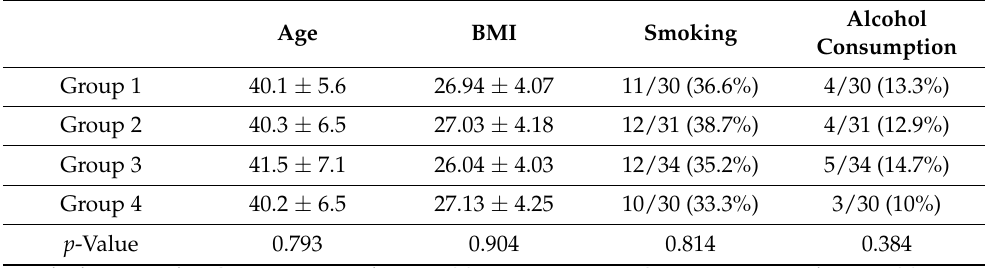
Table 1. Comparison of the study groups in terms of demographic and clinical characteristics. Age BMI